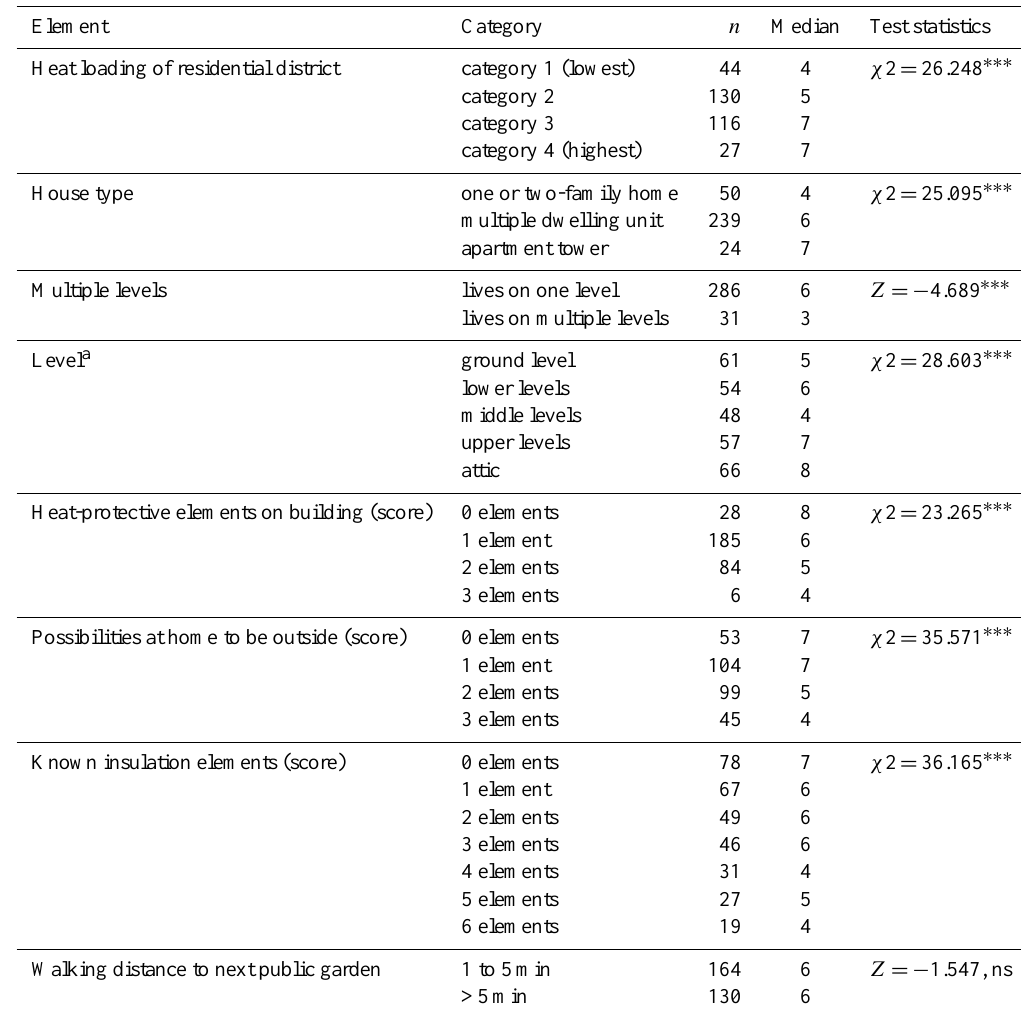
Table 5. Subjective heat stress at home by structural building elements and urban environment.